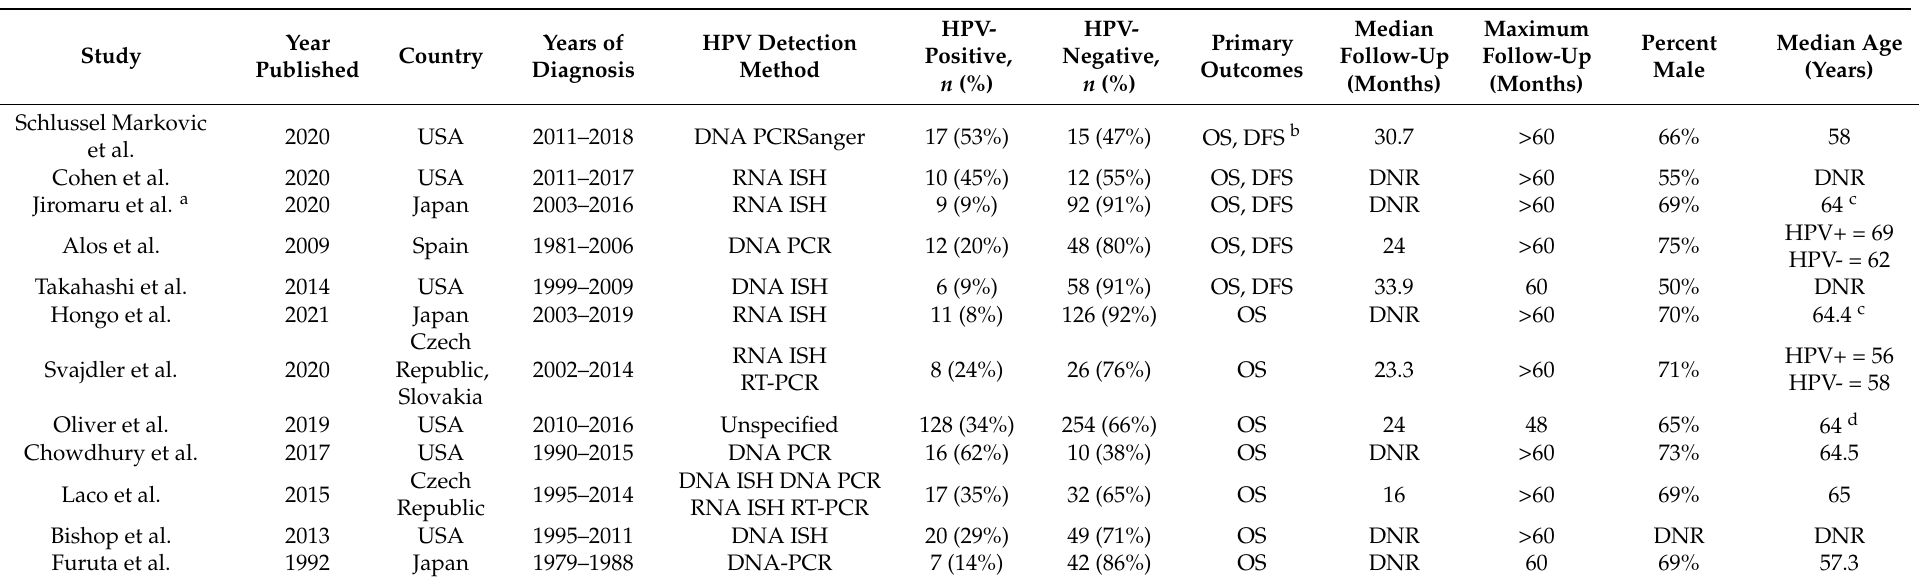
Table 1. Characteristics of studies included in the